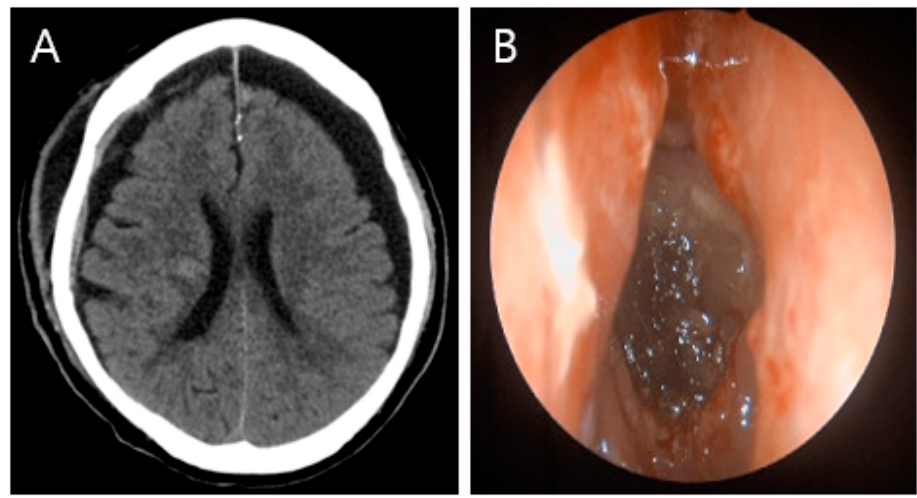
Figure 4. One-month follow-up. ( A ) Brain CT image, showing no specific findings except for bilateral hygroma. ( B ) Nasal endoscopy, showing that the defective area healed well without any specific findings.